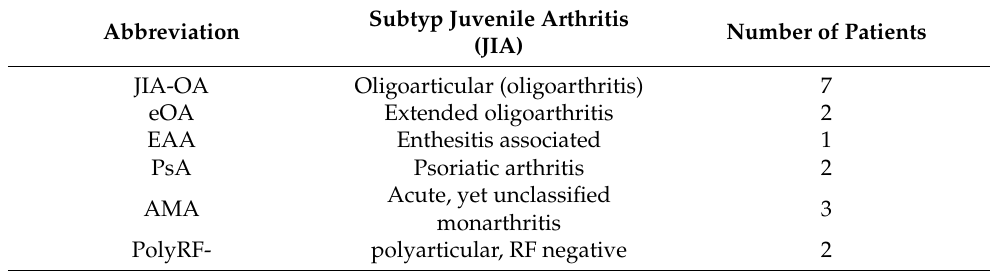
Table 1. Explanations of JIA subtypes and number of patients (8 female, 9 male, aged